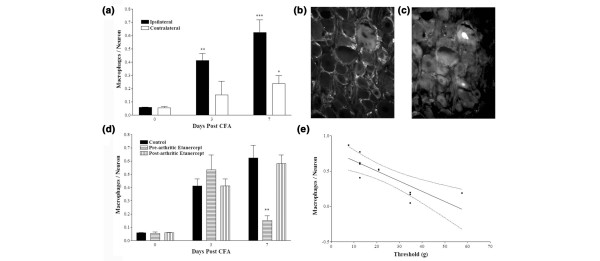
Prearthritic treatment with etanercept reduces postarthritic macrophage accumulation in the dorsal root ganglion (DRG). (a) Inflammation due to complete Freund's adjuvant (CFA) induced a 10-fold increase in perineuronal macrophages (n = 4) by 7 days after inflammation. Infiltration of macrophages was restricted to the ipsilateral side, except for 7 days after inflammation, when a threefold increase in perineuronal macrophages was observed in the contralateral DRG. Nerve damage was assessed through double immunohistochemistry using the macrophage marker, ED1 (b) and a neuropathic marker, ATF-3 (activating transcription factor-3) (c). A maximum of two ATF-3-positive cells was detected per DRG, indicating that little nerve damage occurs in this model. (d) Prearthritic treatment with etanercept reduced macrophage numbers in the ipsilateral DRG by 75% 7 days after inflammation in comparison with controls treated with denatured etanercept (n = 4). No differences in macrophage numbers were detected with etanercept treatment commencing 3 days after inflammation induction. (e) A significant correlation between macrophage numbers in the DRG and mechanical hyperalgesia was observed 7 days after inflammation (n = 12). All treatment groups and controls were plotted. R2 = 0.667, P < 0.01. *P < 0.05,**P < 0.01, ***P < 0.005.